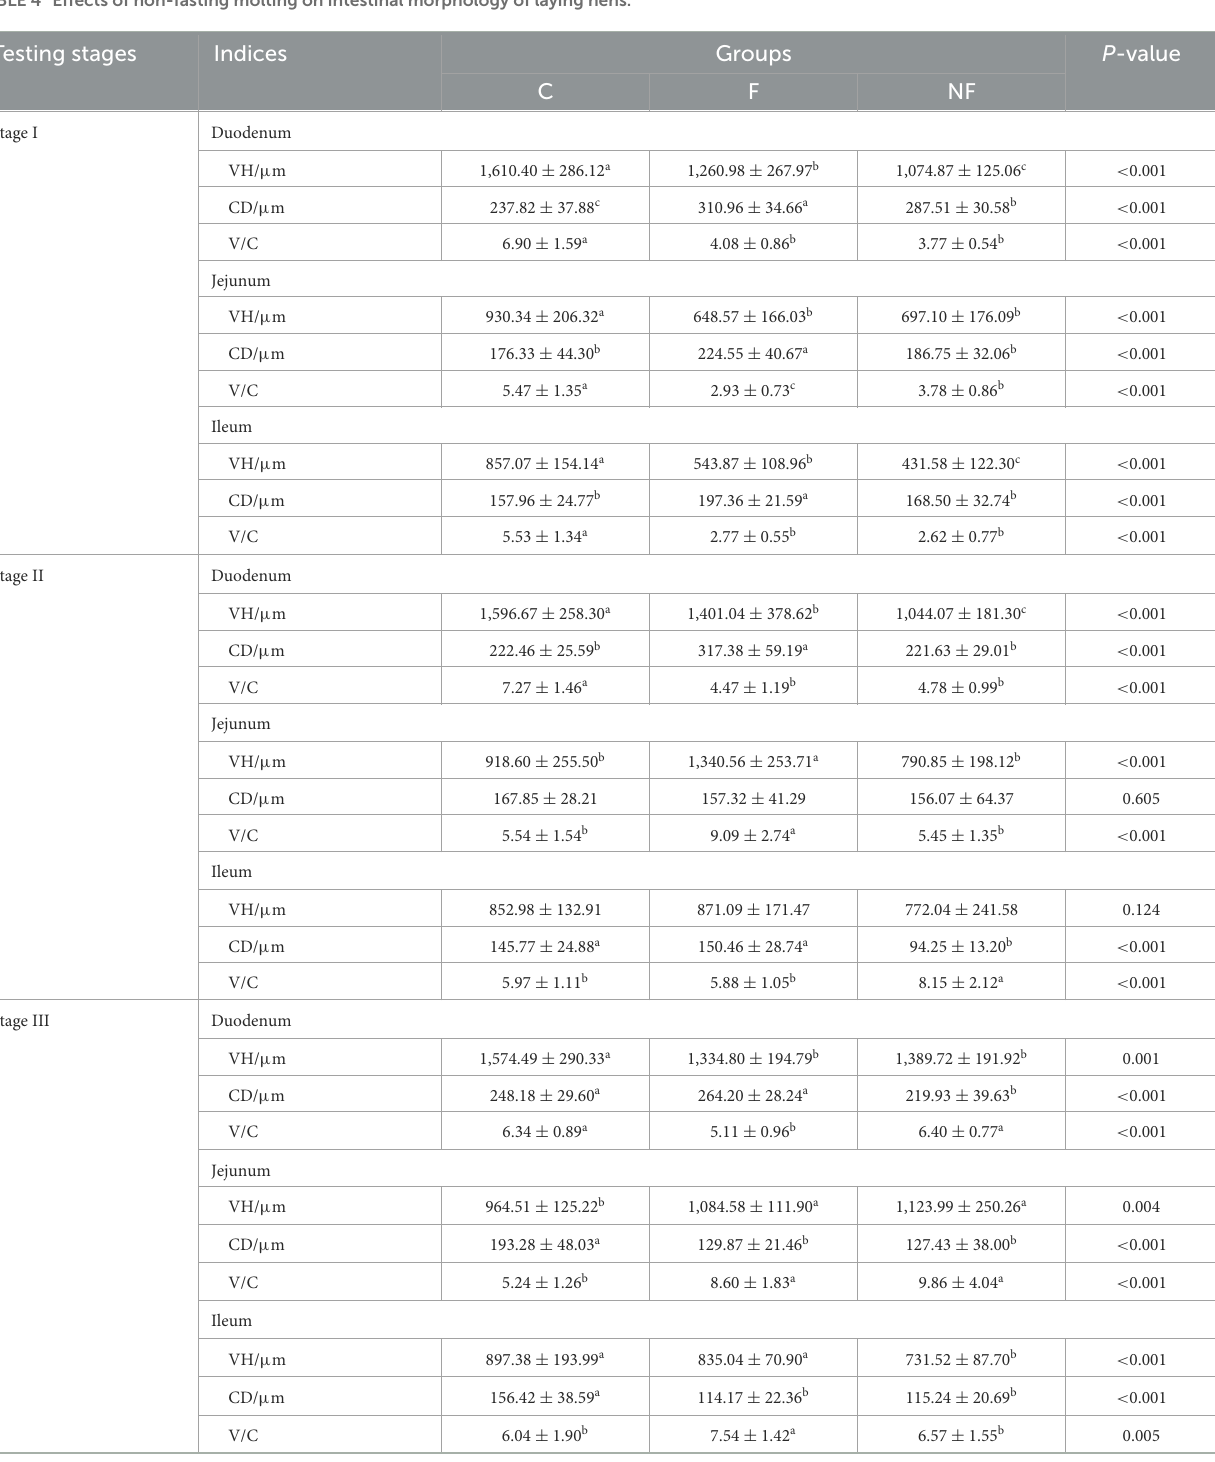
TABLE 4 Effects of non-fasting molting on intestinal morphology of laying